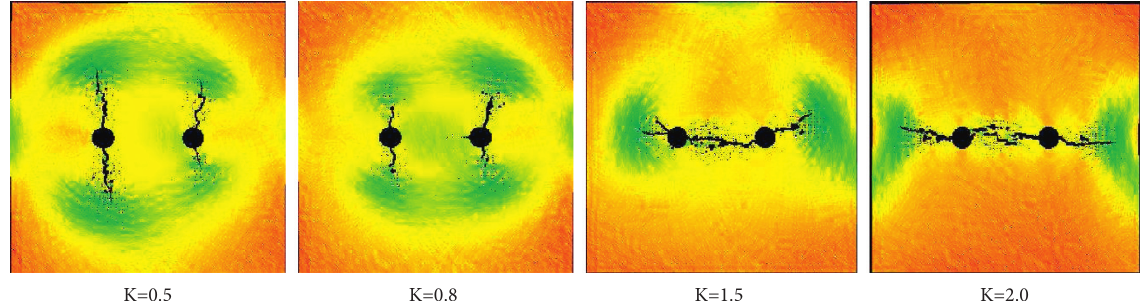
Figure 9: Morphology of hydraulic fractures with different stress ratio ( m � 2, L � 130